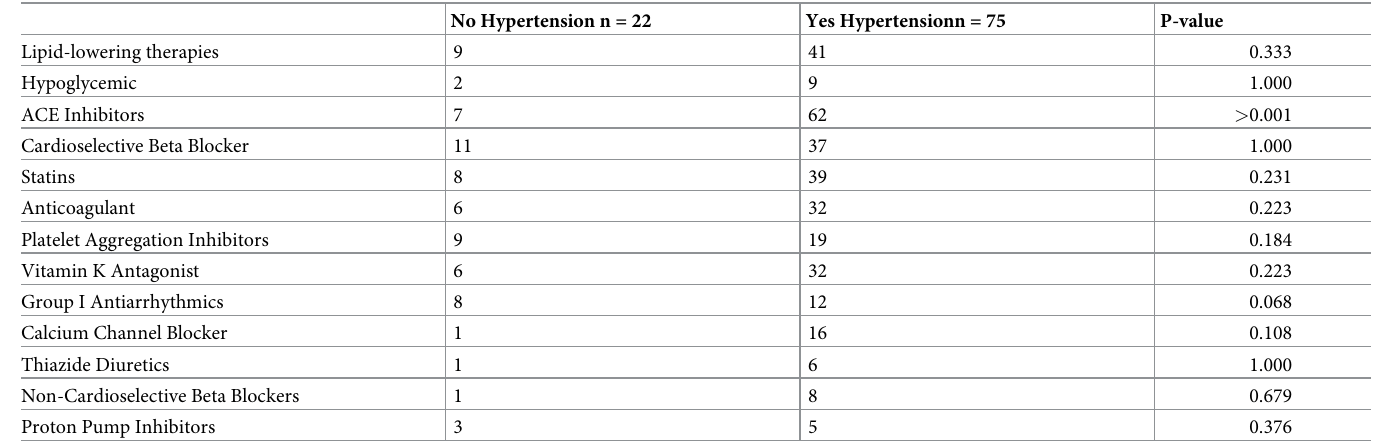
Table 2. Treatment data.